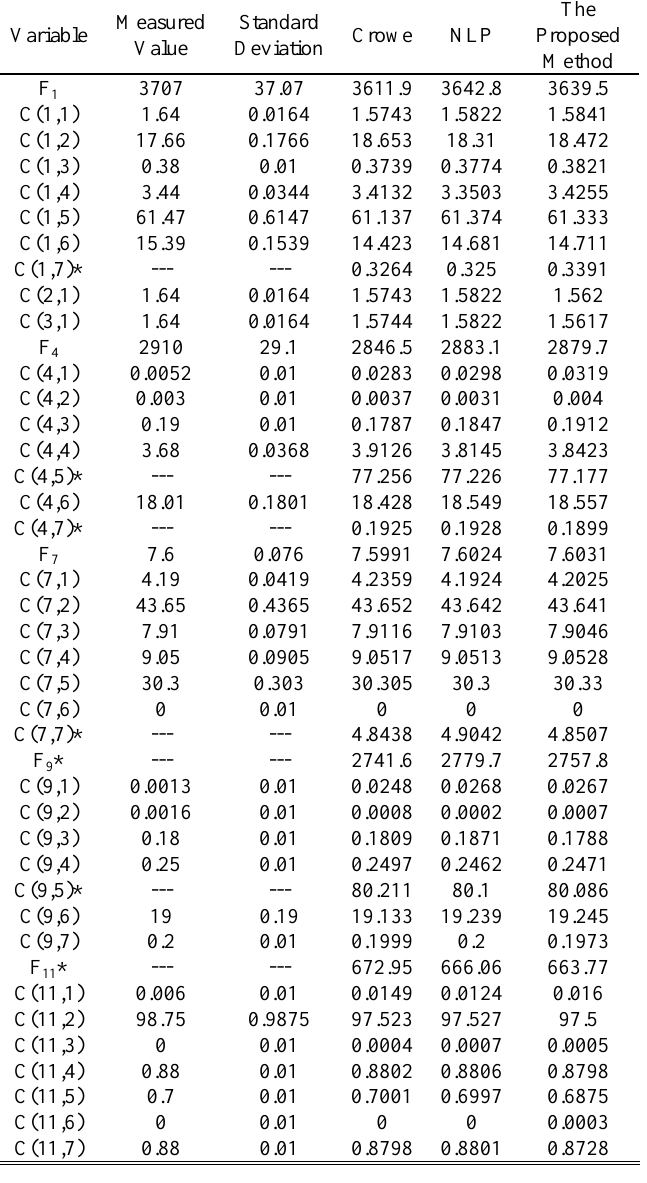
Table 5. Reconciliation results using Crowe, NLP and the proposed algorithm